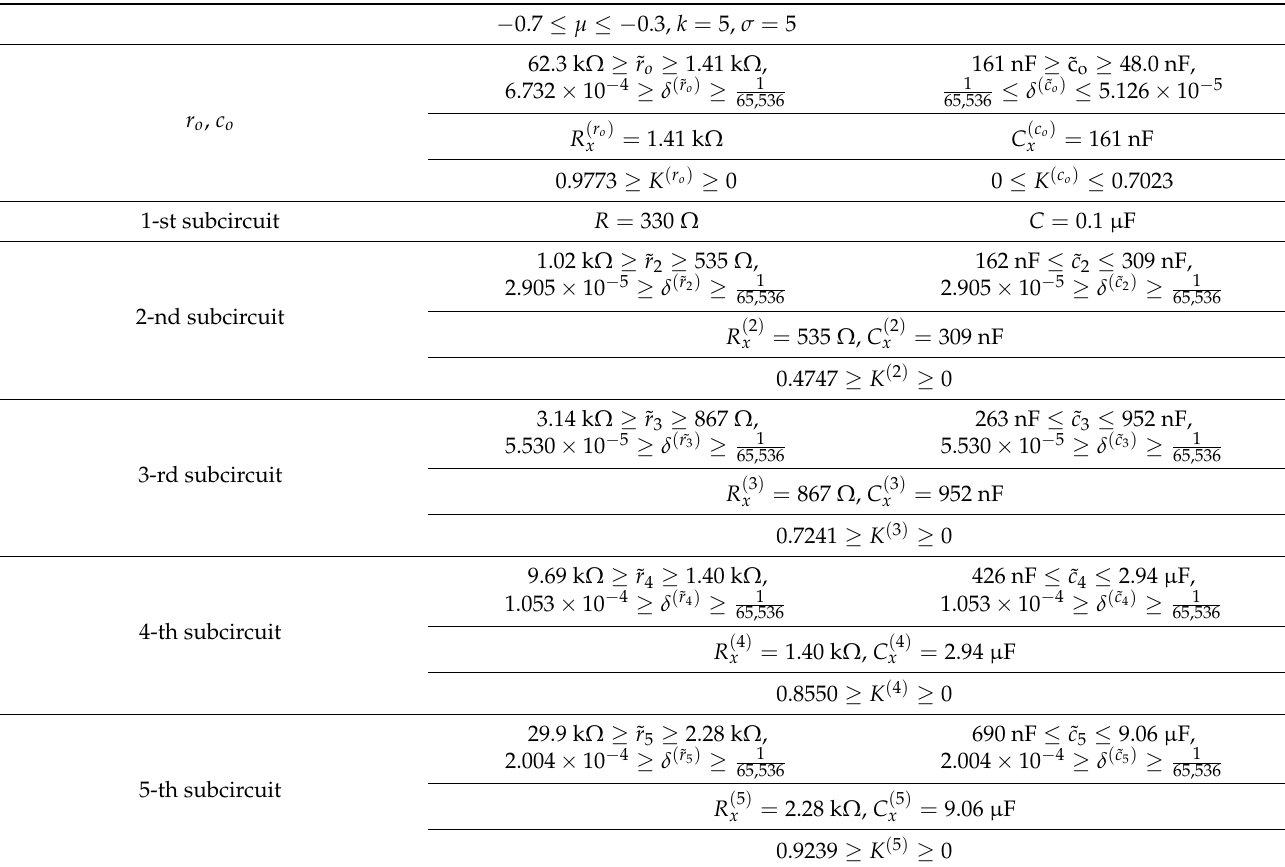
Table 1. Circuit parameter